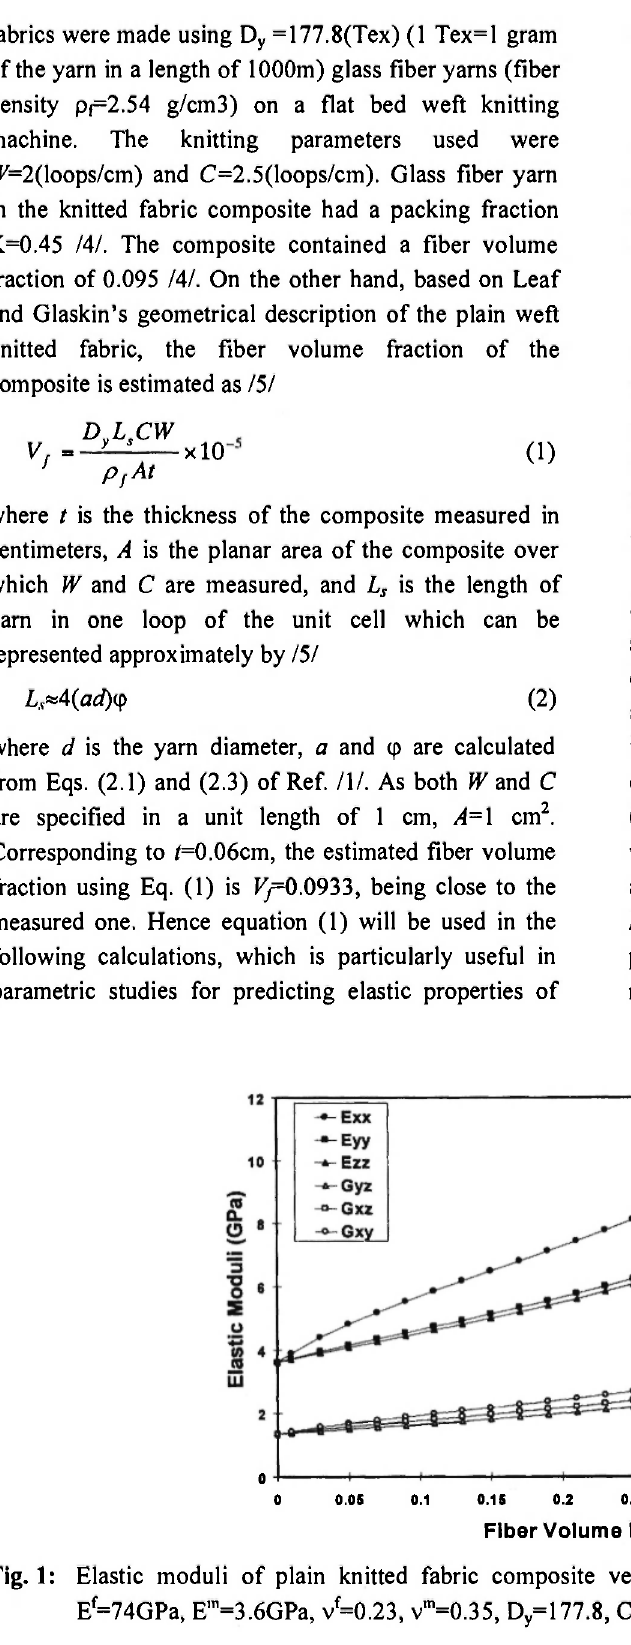
Fig. 1: Elastic moduli of plain knitted fabric composite versus fiber volume fraction. The parameters used are: E f =74GPa, E m =3.6GPa, v f =0.23, v m =0.35, D y =177.8, C=2.5 loop/cm, W=2 loop/cm, and